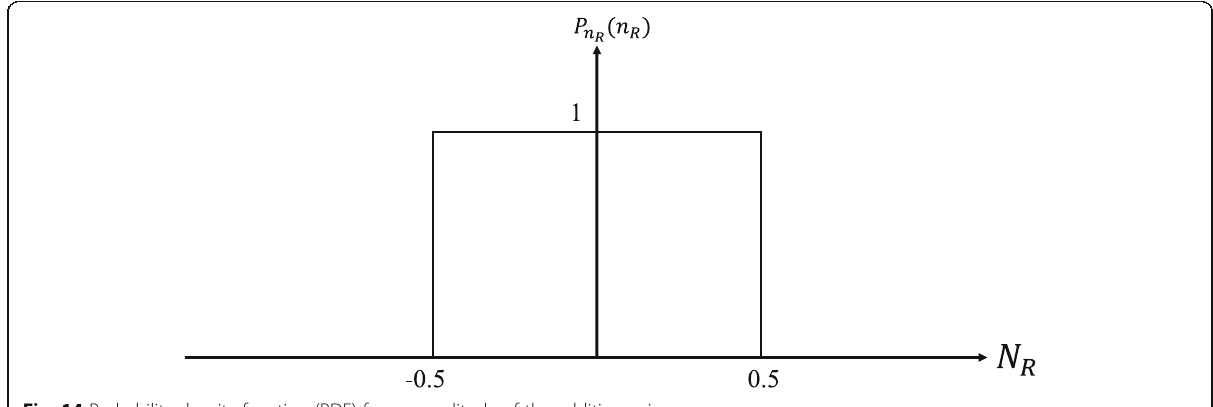
Fig. 14 Probability density function (PDF) for an amplitude of the additive